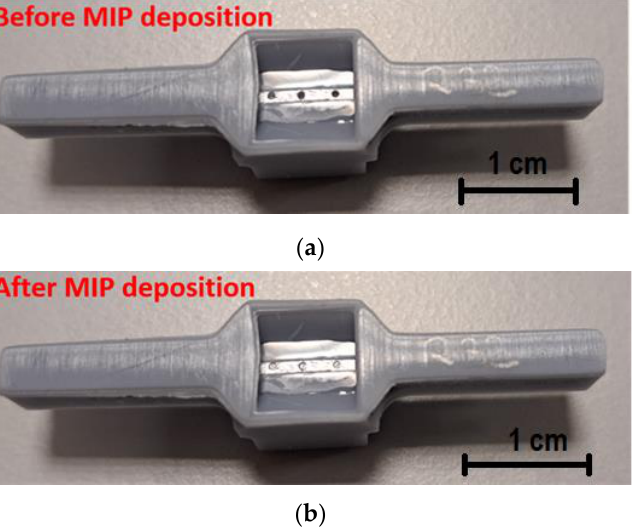
Figure 2. Picture of the POF – chemical chip before ( a ) and after ( b ) the MIP deposition step.